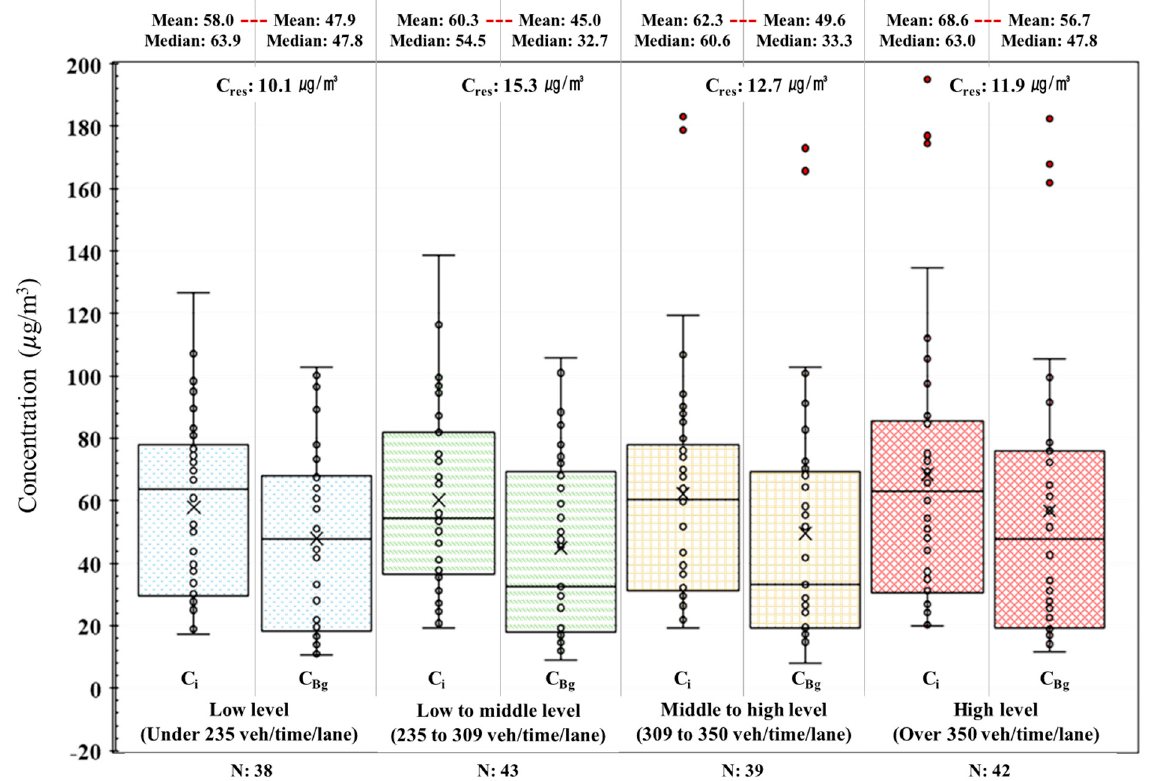
Figure 13. Comparison of Box plot by lane traffic level types.